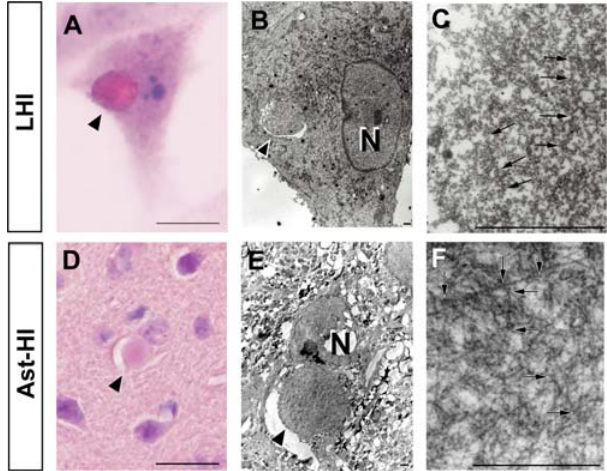
Figure 5. LHIs containing granule-coated fibrils are morphologically identical with Ast-HI from L84V transgenic mice. ( A–F ) Comparison of a LHI induced by ER stress in an L84V SOD1-expressing SK-N-SH cell (A– C) and Ast-HI in the spinal cord of a transgenic L84V SOD1 mouse (D–F). ( A ) An eosinophilic LHI in the cytoplasm of the SK-N-SH cell expressing L84V SOD1 cell was induced by treatment with 1 m g/ml of tunicamycin for 24 h (scale bar=20 m m). ( B ) Electron micrograph of a hyaline inclusion (arrow) obtained by the direct epoxy resin-embedding method after decolorization of the HE-stained section shown in ( A ). N, nucleus; 6 3000 (scale bar=1 m m). ( C ) At a high magnification, the inclusion is composed of granule-coated fibrils (arrows) approximately 15–25 nm in diameter and granular materials. 6 16000 (scale bar=1 m m). ( D ) An eosinophilic Ast-HI from a transgenic L84V SOD1 mouse. ( E ) Electron micrograph of an Ast-HI obtained by the direct epoxy resin-embedding method mentioned in ( B ). N, nucleus; 6 2000 (scale bar=1 m m). ( F ) Enlargement of ( E ). 6 16000 (scale bar=1 m m). Note that the fibrils observed in ( C ) and ( F ) are ultrastructually identical.